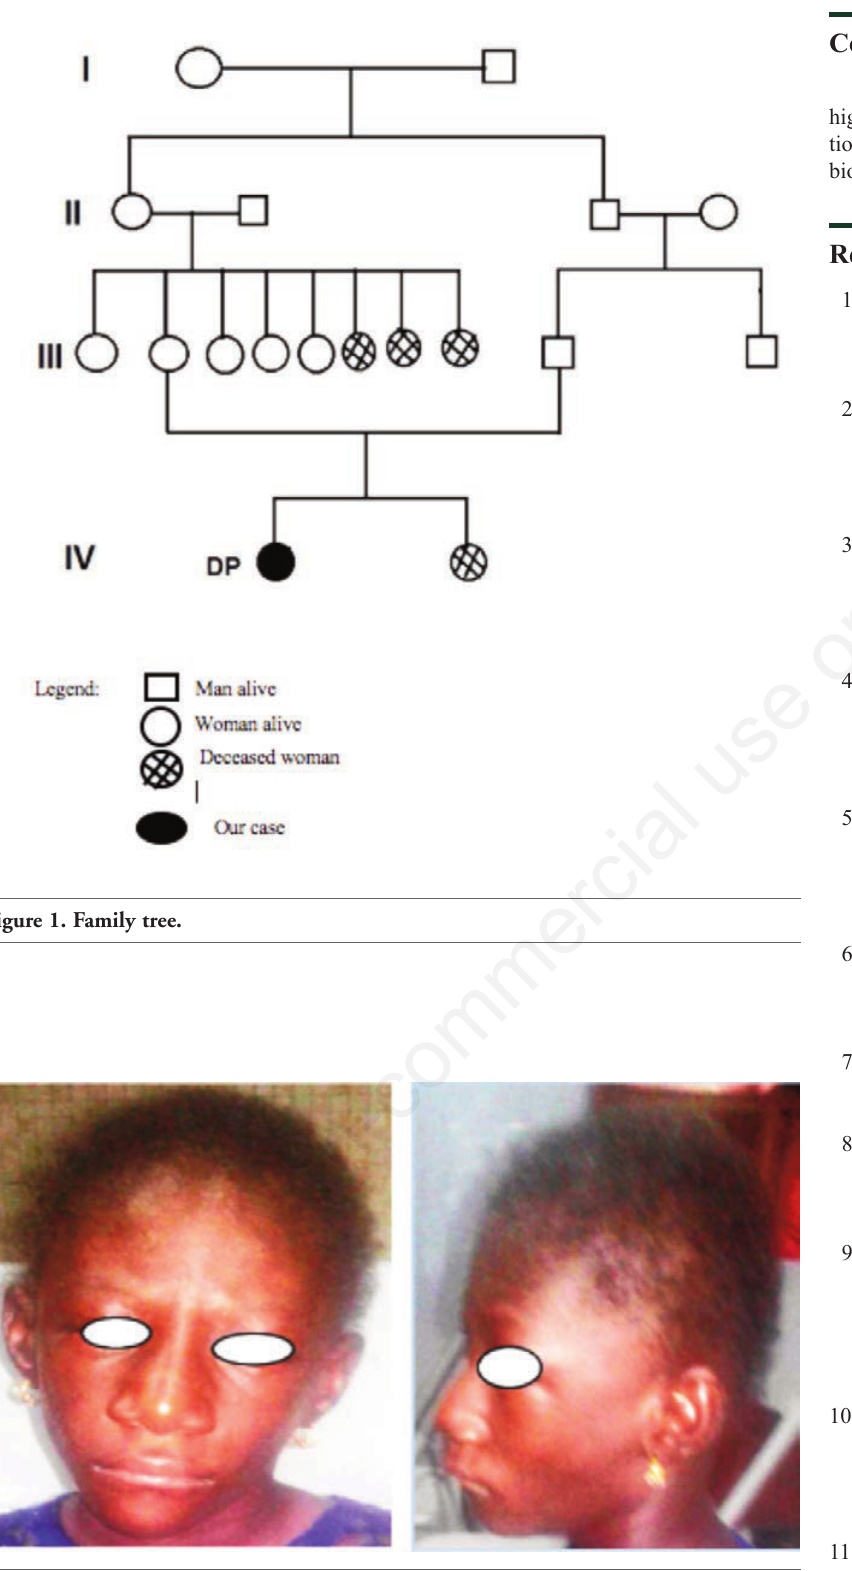
Figure 2. Characteristic facial dysmorphism with prominent beak-shaped nose, microg- nathia, low-set